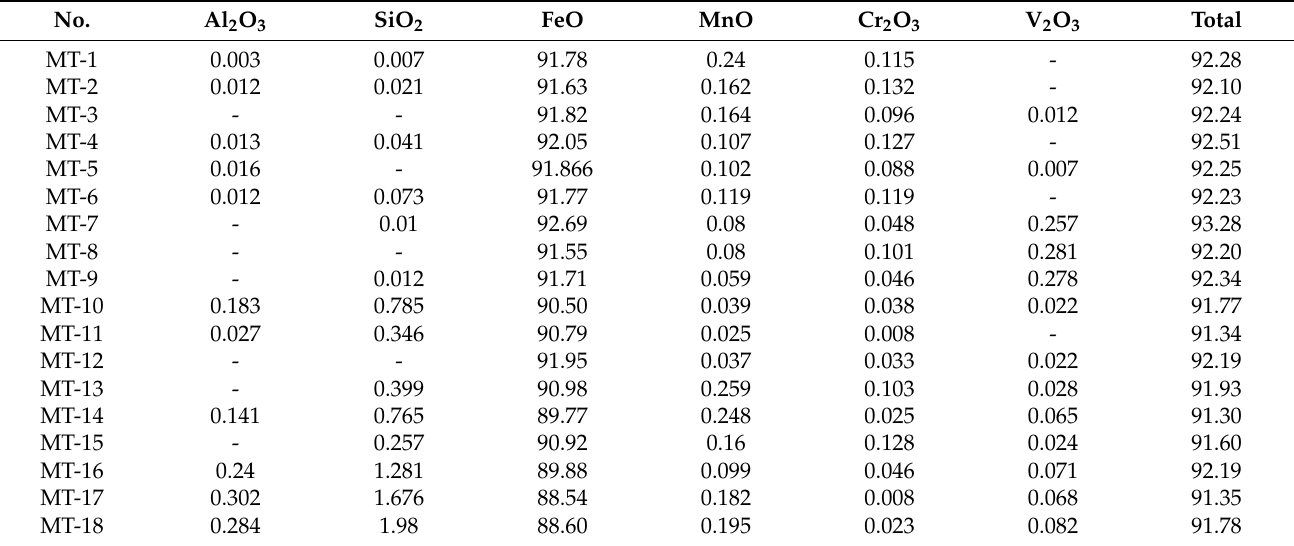
Table 1. Selected EPMA analyses of magnetite grains from the Dongping deposit